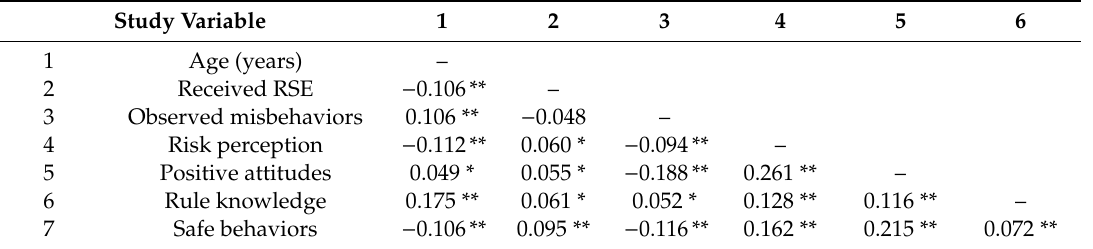
Table 2. Bivariate (Spearman) correlations between study